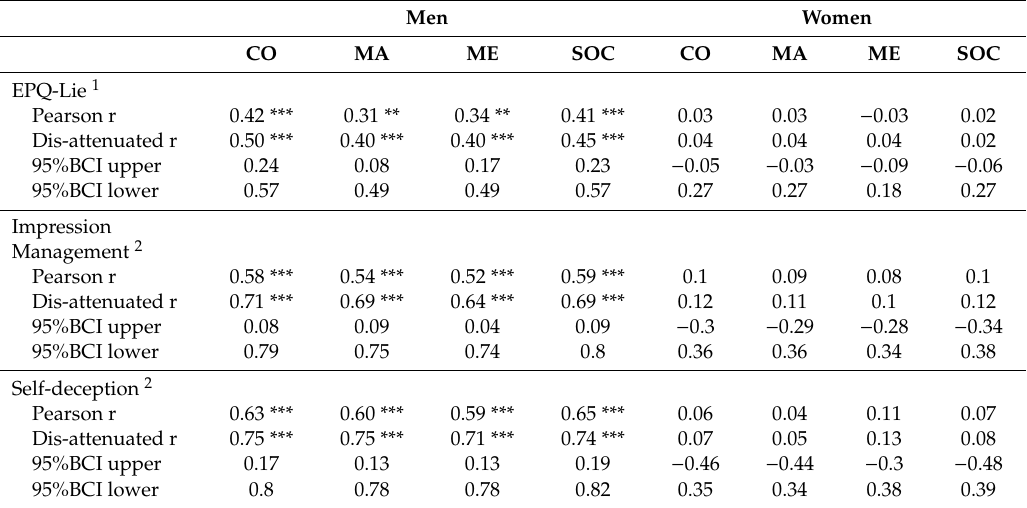
Table 2. Correlations, dis-attenuated correlations, and bias-corrected bootstrap confidence intervals (95%BCI) between the OLQ scales and the questionnaires measuring social desirability among men and